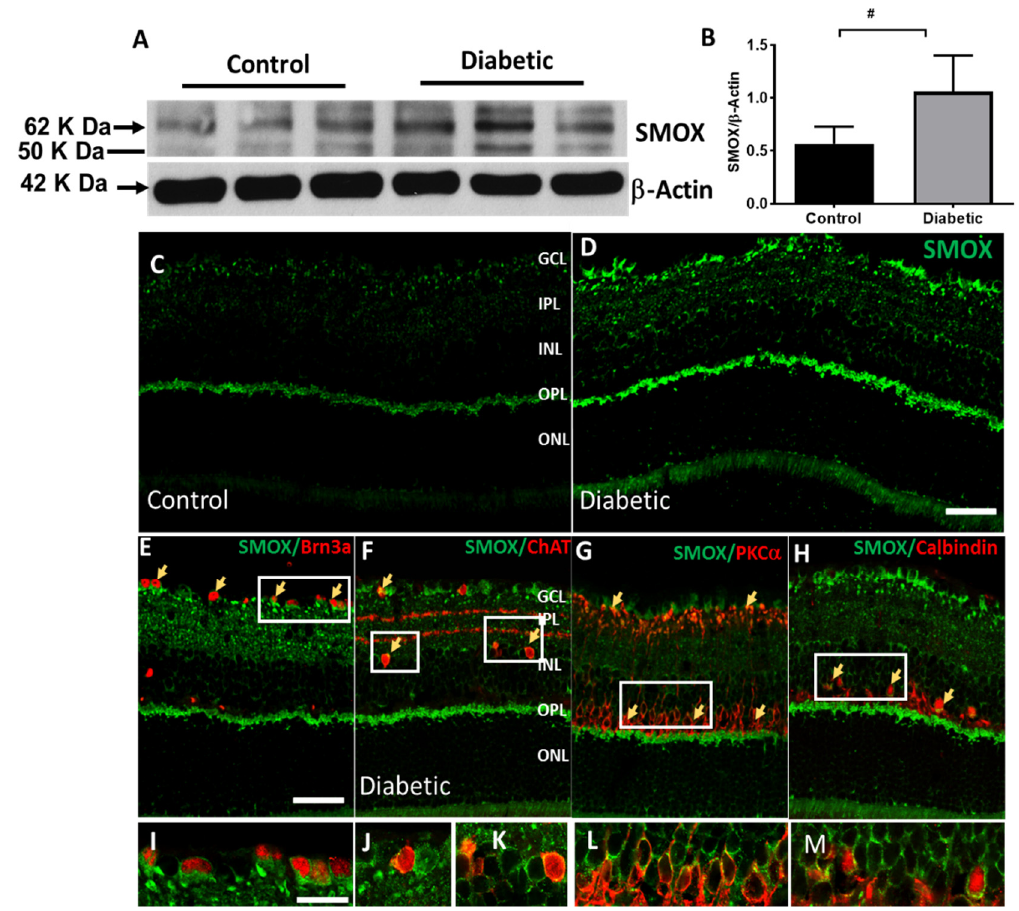
Figure 2. Increased spermine oxidase (SMOX) expression in the diabetic retina. ( A,B ) Western blot analysis and quantification showing elevated expression of SMOX in the 4 weeks diabetic retina. Data represented as mean ± SD. # p < 0.01. N = 6 per group. ( C,D ) Confocal images showing SMOX expression on control and diabetic retinal sections. Increased expression of SMOX in the ganglion cell layer (GCL), inner nuclear layer (INL), and outer plexiform layer (OPL) of the diabetic retina. ( E–H ) Colocalization studies showing SMOX expression in retinal ganglion cells (Brn3a positive), amacrine cells (ChAT positive), bipolar cells (PKC α positive), and horizontal cells (calbindin positive). Areas of colocalization are represented by arrows. Scale bar 50 µ m. ( I–M ) High magnification images of SMOX colocalization in the diabetic retina. Scale bar 20 µ m. N = 4–6 were included per group, and representative images are presented.